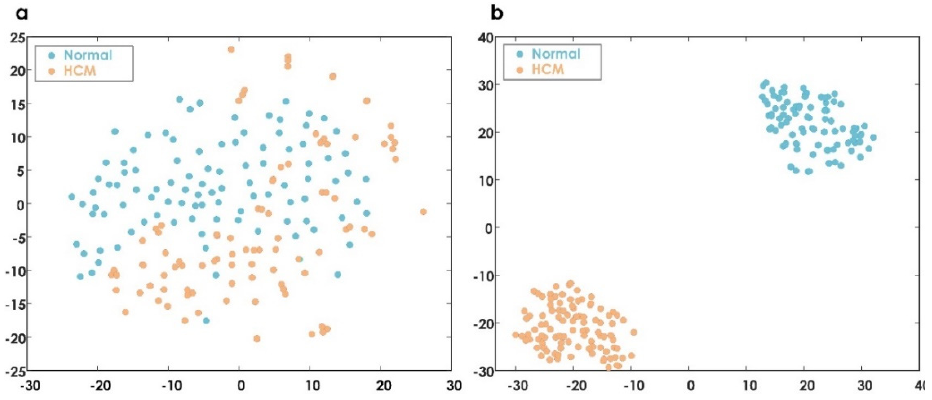
Figure 12. ( a ) Using complete feature space, and ( b ) using the 10 most significant LDP RNet50 fea- tures.